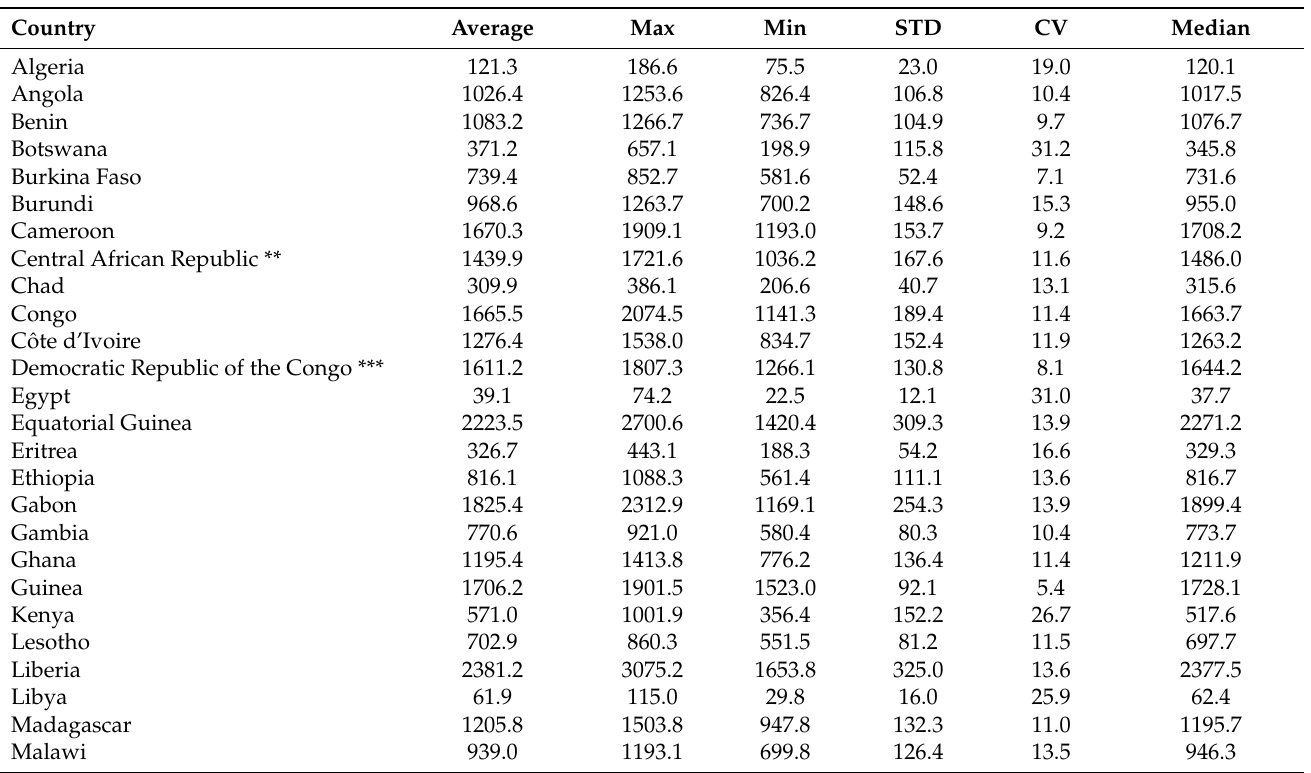
Table A1. Descriptive statistics for annual rainfall (in mm) for countries from TAMSAT data (1983 to